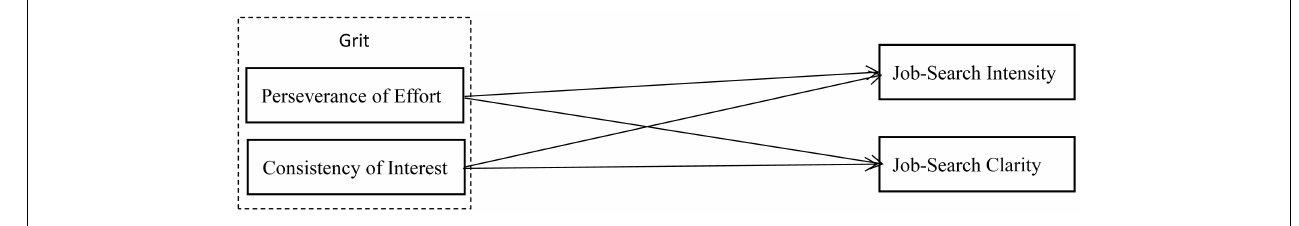
FIGURE 1 | The proposed model of the